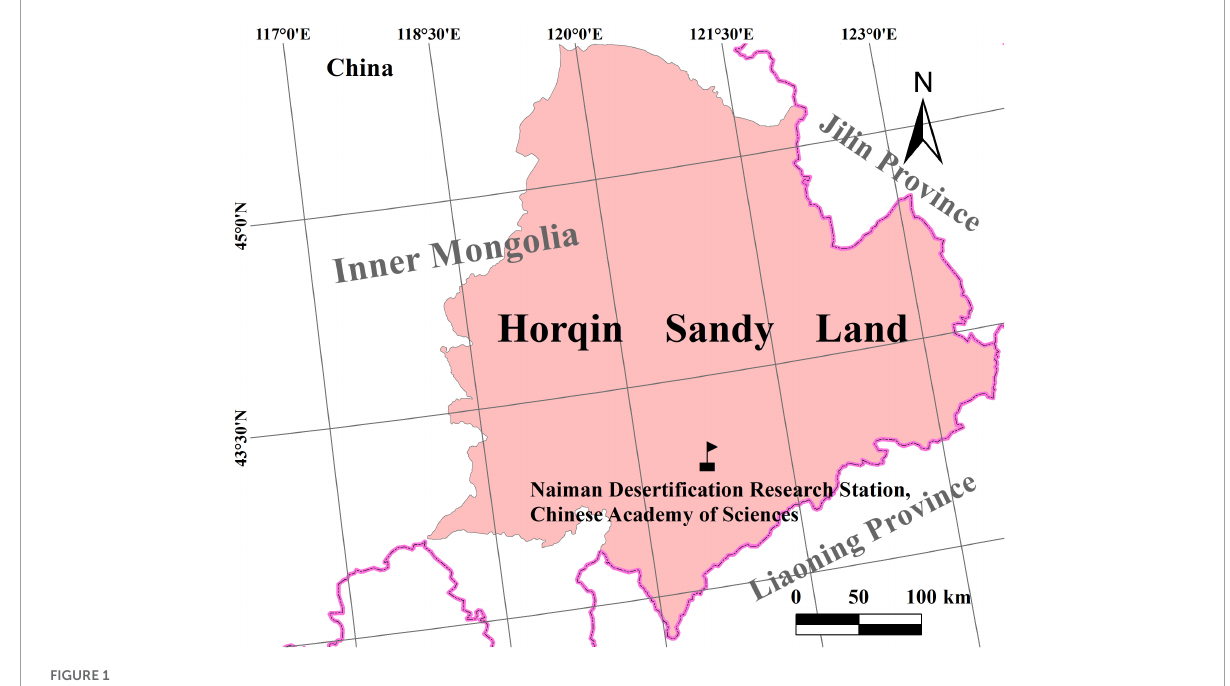
FIGURE1 Study area of the Horqin